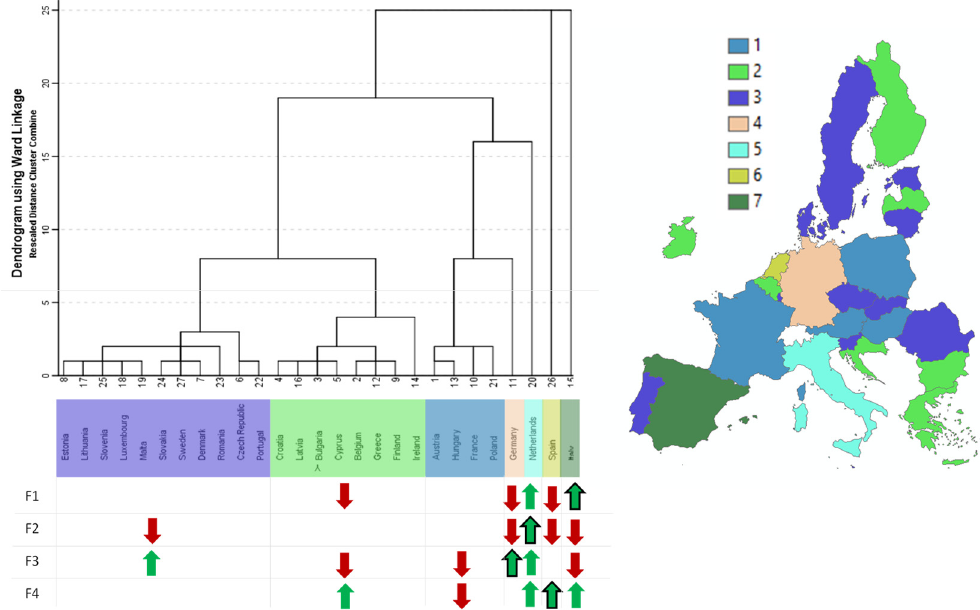
Figure 10. Loadings of the principal component analysis.